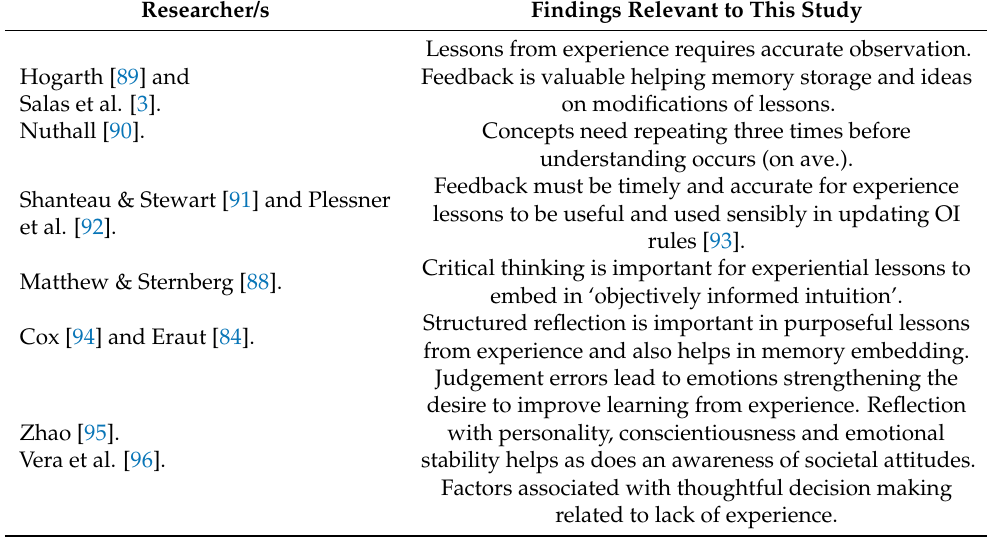
Table 4. Examples of research on experiential influences on ‘objectively informed